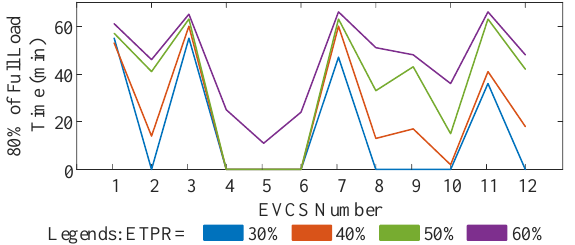
Figure 10. As the rated power of quick charging of taxis is 50 kW and that of quick chargers is 60 kW, the scenario analyzed in this figure is that the load of each EVCS reaches 80% of the full load.